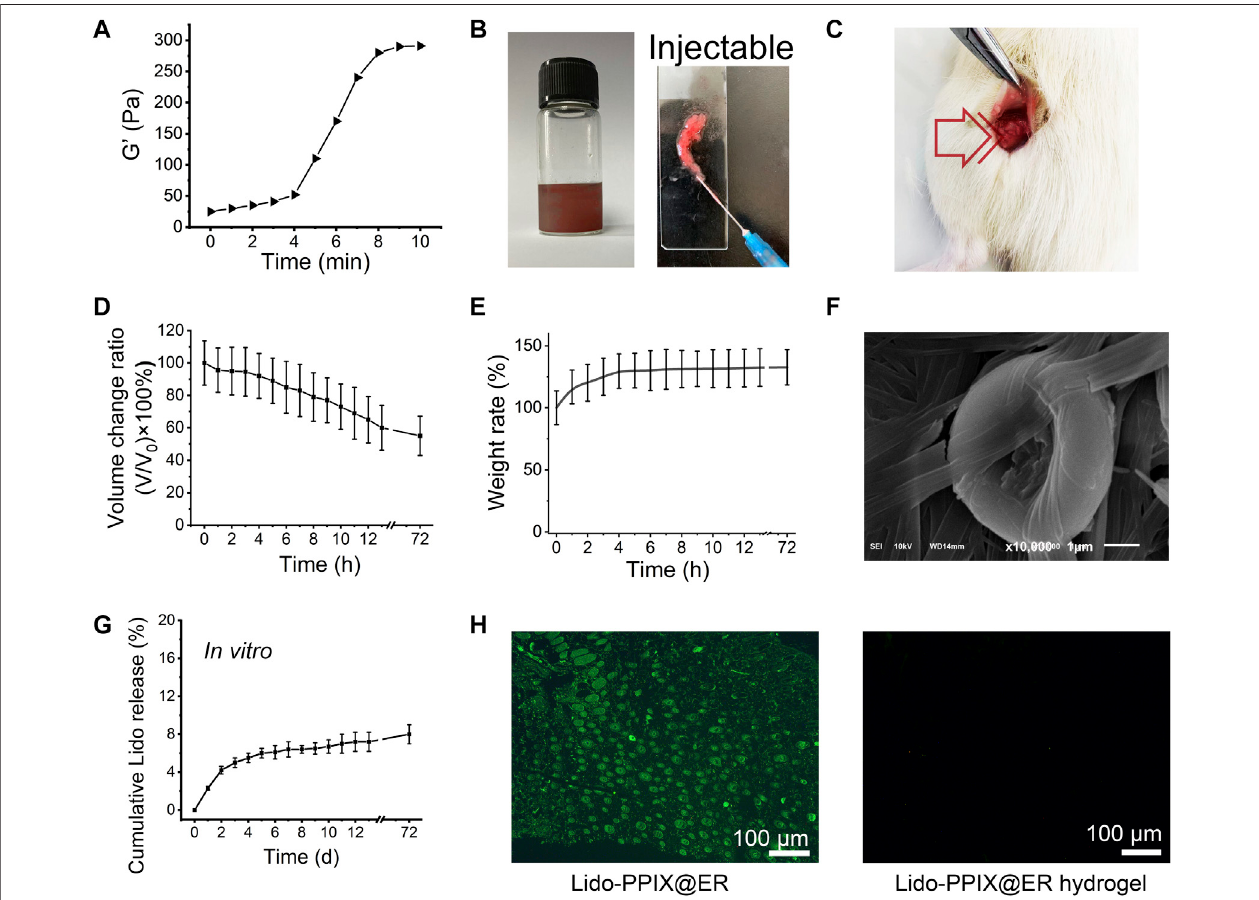
FIGURE3| CharacterizationoftheLido-PPIX@ERhydrogel. (A) RheologypropertiesofPFL-catalyzedFmoc-Phe 3 . (B) Photographsshowingthegelationbehavior of the Lido-PPIX@ER hydrogel after adding PFL for 2 and 10 min and photograph of the injectable Lido-PPIX@ER hydrogel. (C) Photograph of peptide hydrogel in vivo . Thepeptidehydrogelwassubcutaneouslyinjectedwithin2 min.Tenminuteslater,themixtureandPFLcouldalsoshiftfromliquidtoahomogeneousgelstate invivo . (D) VolumechangecurveoftheLido-PPIX@ERhydrogelinPBSat37 ° C. (E) Weightfractioninprecentvs.timeofLido-PPIX@ERhydrogelinPBSat37 ° C. (F) TheSEM imge of Lido-PPIX@ER hydrogel. (G) Stability of Lido-PPIX@ER hydrogel in vitro . (H) Immunohistochemical staining for f4/80 to identify in fi ltrated macrophages in the subcutaneous tissues. The experiment was repeated at least three